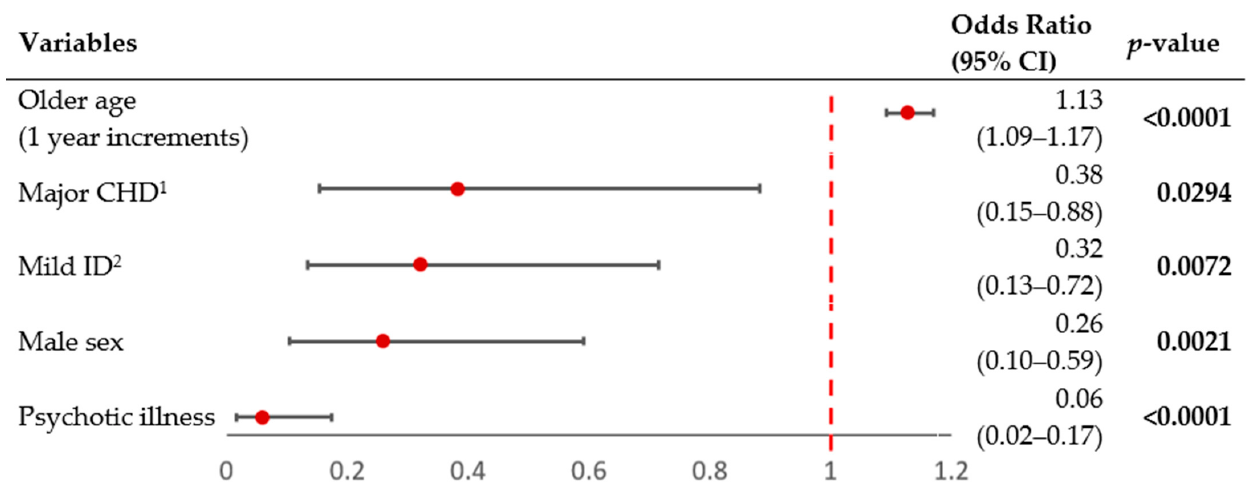
Figure 1. Forest plot of logistic regression model for reproductive fitness in adults with 22q11.2DS. The figure shows odds ratios (OR, red circles) and 95% confidence intervals (CI, horizontal lines) for five possible predictors of reproductive fitness in 368 adults with a 22q11.2 microdeletion. The overall logistic regression model was significant (likelihood ratio χ 2 = 112.7, df = 5, p < 0.0001). Significant values are shown in bold font. 1 CHD = congenital heart disease. 2 ID = intellectual disability.